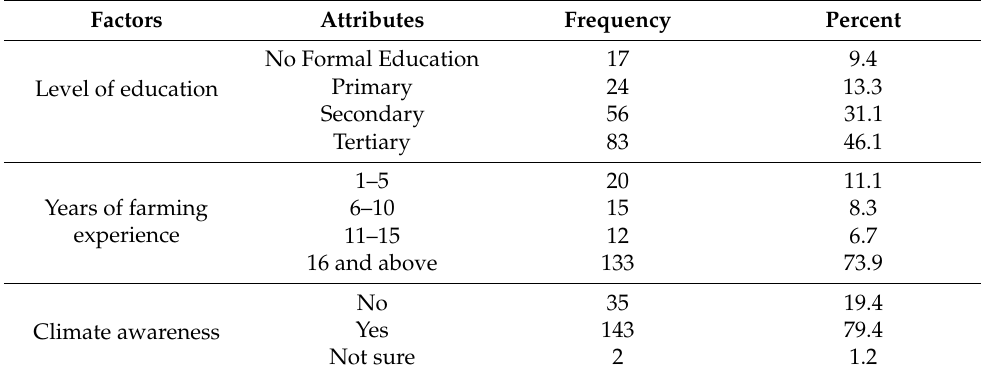
Table 5. Education, experience, and awareness